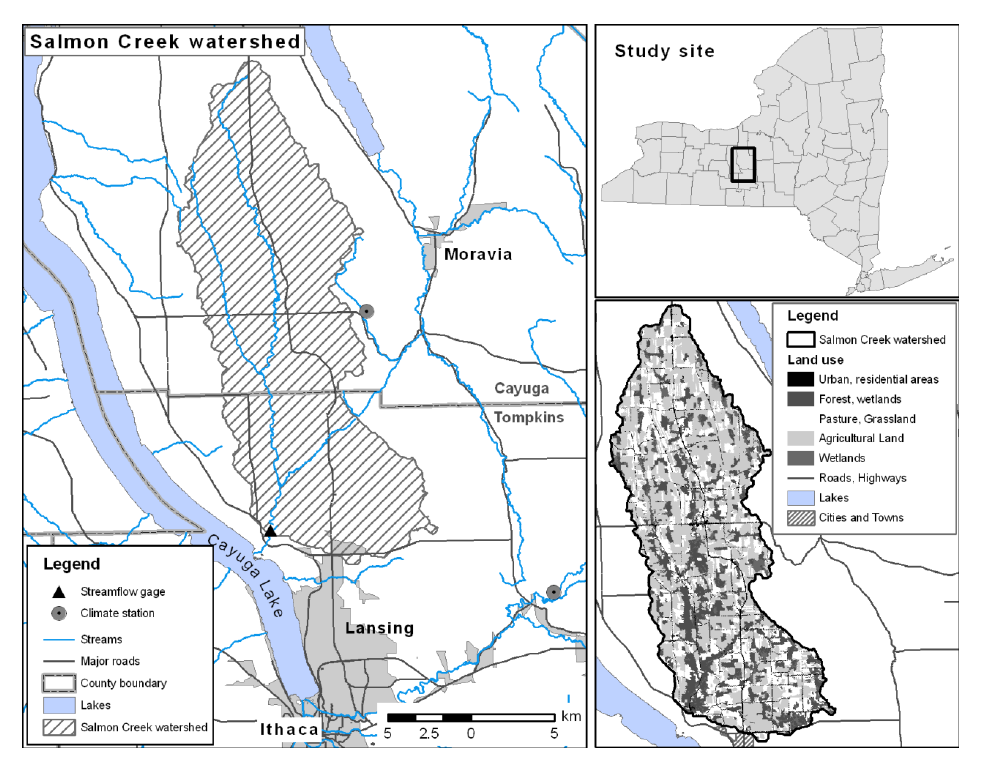
Figure 6. Location and characteristics of Salmon Creek